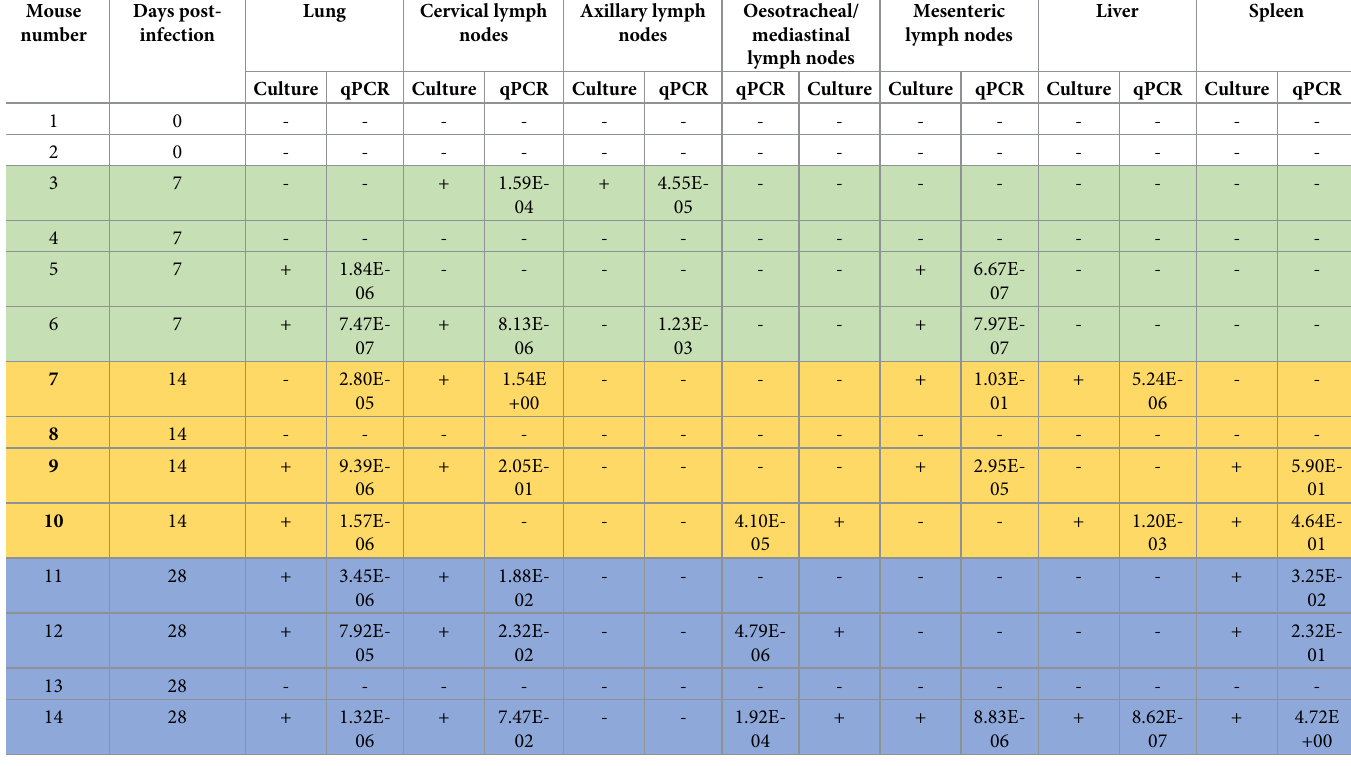
Table 1. Culture result and microbial load data a for organs sampled from mice challenged with M . tuberculosis . Mouse Days post- number